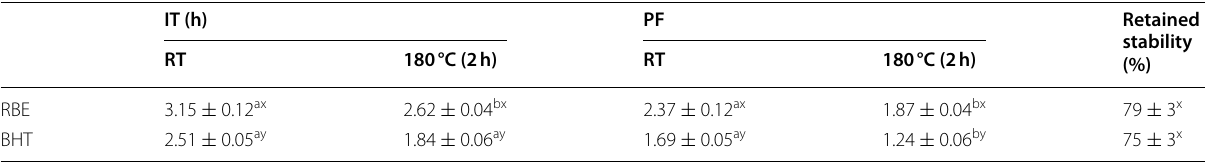
IT of the control 1.48 0.03 h. Data presented as mean = ± protection factors (PF). Letters x and y indicate significant difference in a column (